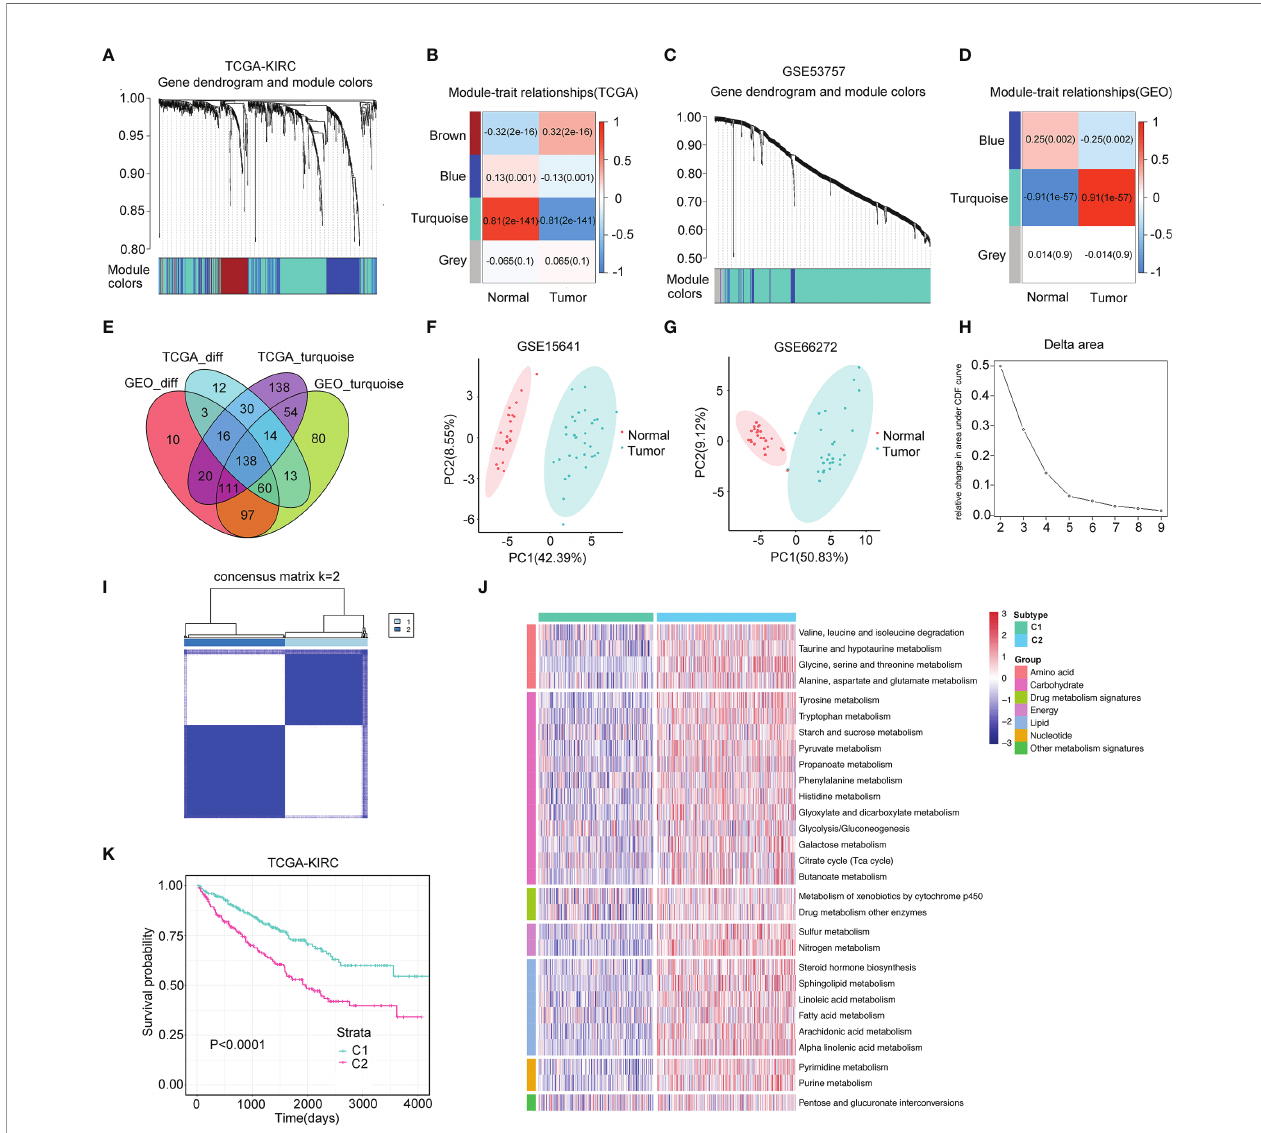
FIGURE 2 | Two distinct metabolism subtypes are identi fi ed. (A) The weighted gene co-expression network analysis (WGCNA) is conducted with metabolism-related genes in TCGA-KIRC. (B) Four gene modules are generated, and the turquoise module presents the highest correlation with sample type. (C) WGCNA is conducted with metabolism-related genes in GSE53757. (D) Three gene modules are generated, and the turquoise module presents the highest correlation with sample type. (E) One hundred thirty-eight overlapping genes in the intersection of the four gene modules are identi fi ed for further univariate Cox analysis. (F, G) Principle component analyses (PCAs) are performed for another two datasets (GSE15641 and GSE36895), and 56 DE-MRGS can clearly separate tumor samples with normal samples. (H, I) The cumulative distribution function curves of consensus matrix indicate that when k=2, the interference between subgroups is minimal. (J) Heatmap of the seven categories of metabolism pathways for two subtypes (C1 and C2). (K) Survival analysis between two metabolism subtypes. p -value is given by log rank